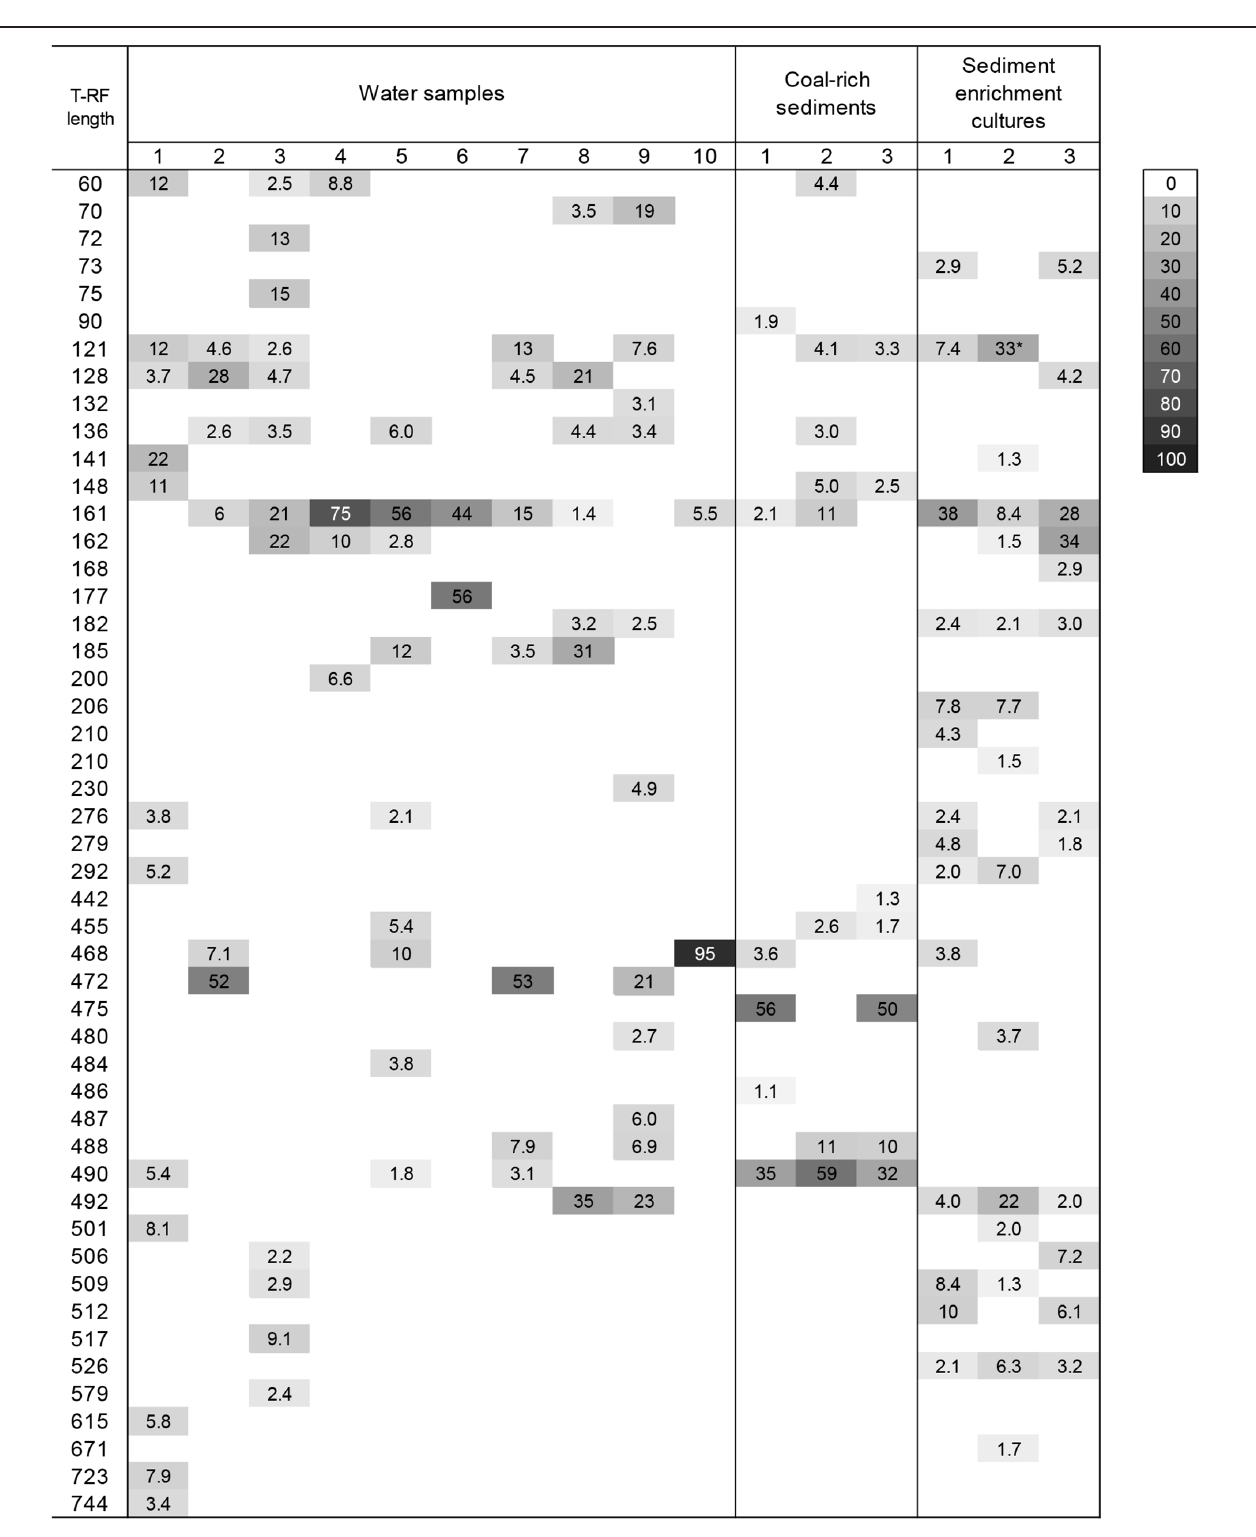
cultures amended with n -hexadecane. The gray scale indicates the relative abundance of each fragment. Only values above 1% are given. *The abundance of this peak equals the maximum abundance for the